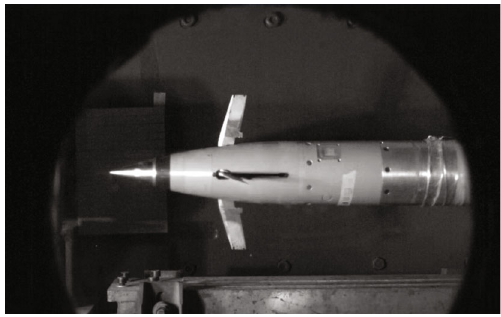
Figure 3: Sine ruddering